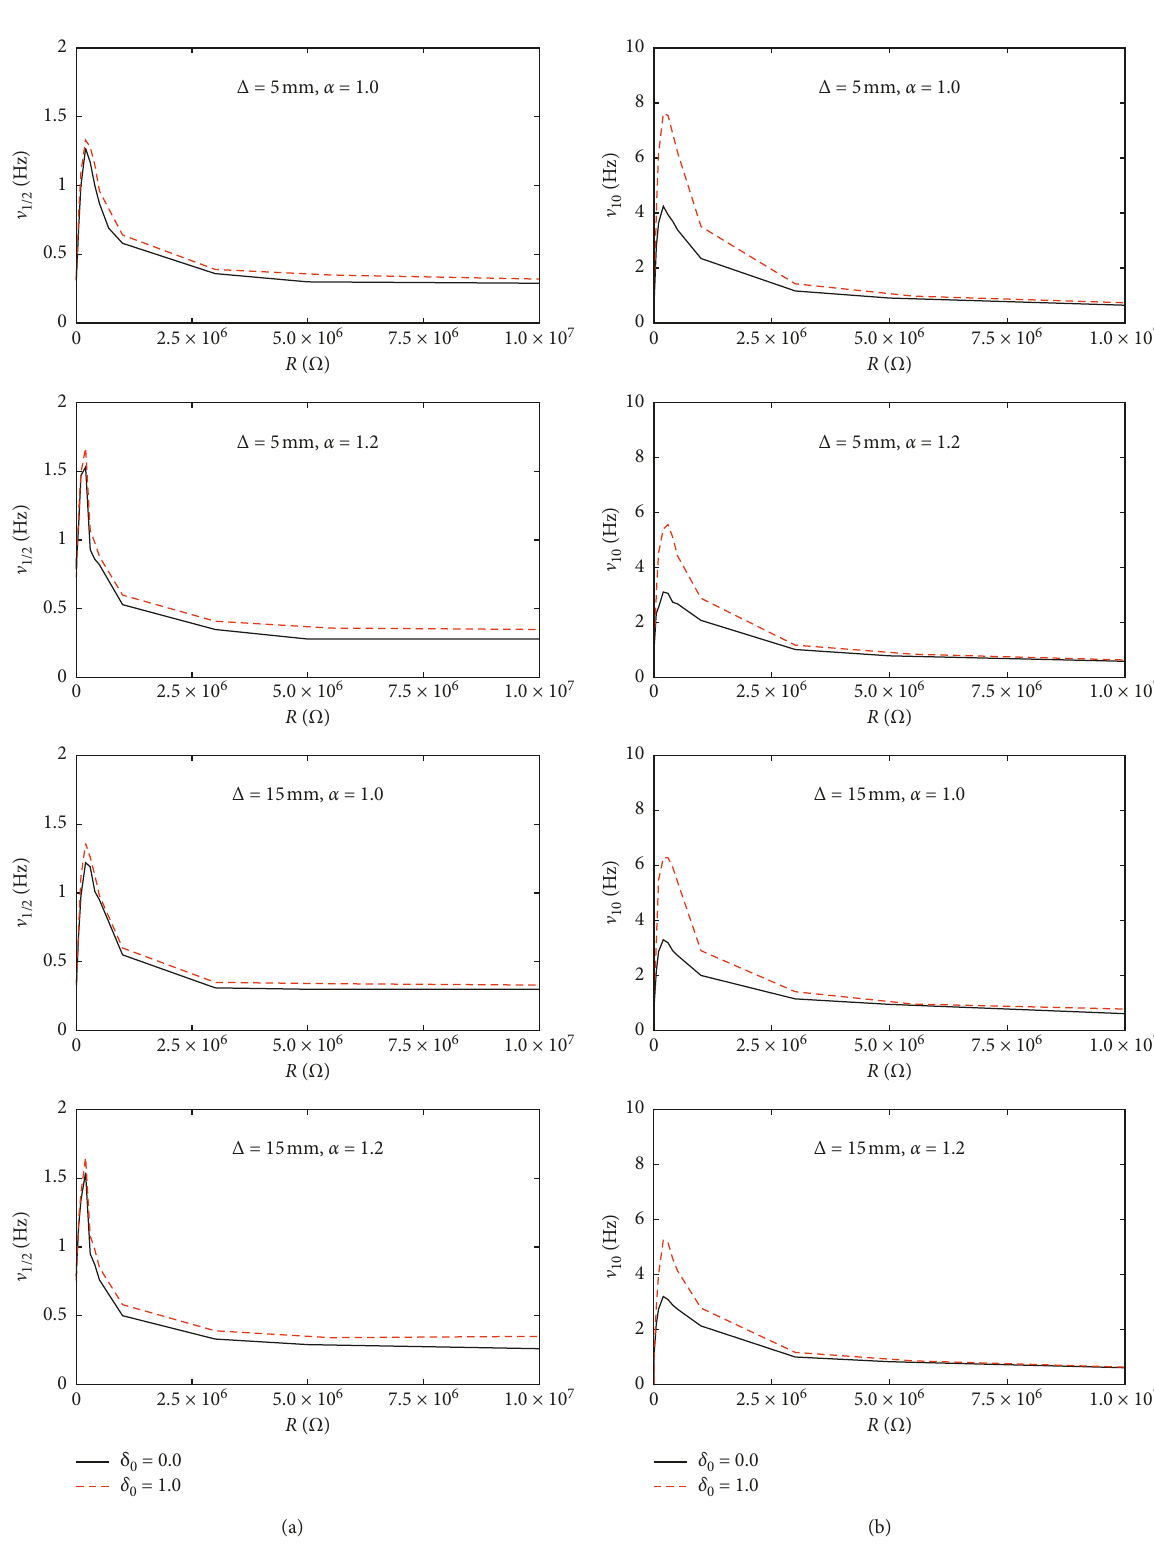
Figure 11: The effective frequency range of the oscillators versus the load resistance R